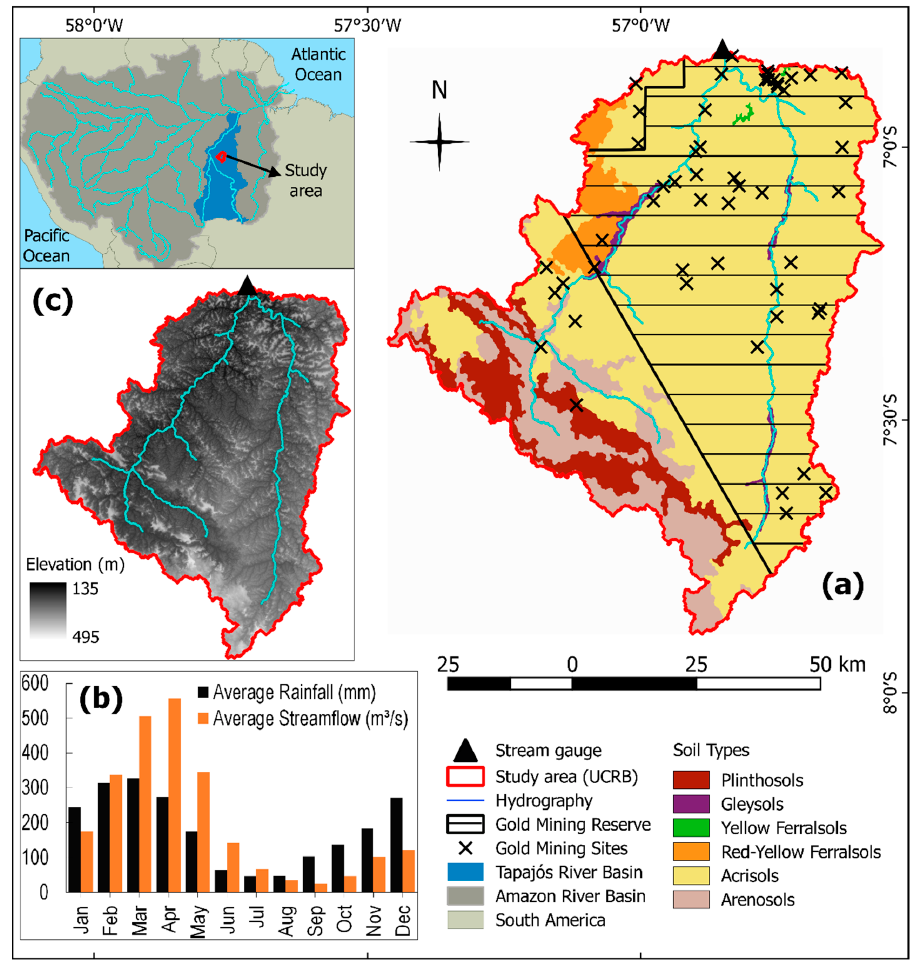
Figure 1. Study area, with rainfall and streamflow data: ( a ) Upper Crepori River Basin (UCRB) location and soil types; ( b ) average rainfall (climatological normal for the period between 1981 and 2010) and streamflow averages for the period between 2002 and 2007 in the UCRB [34,35]; ( c ) Digital elevation model of the UCRB.